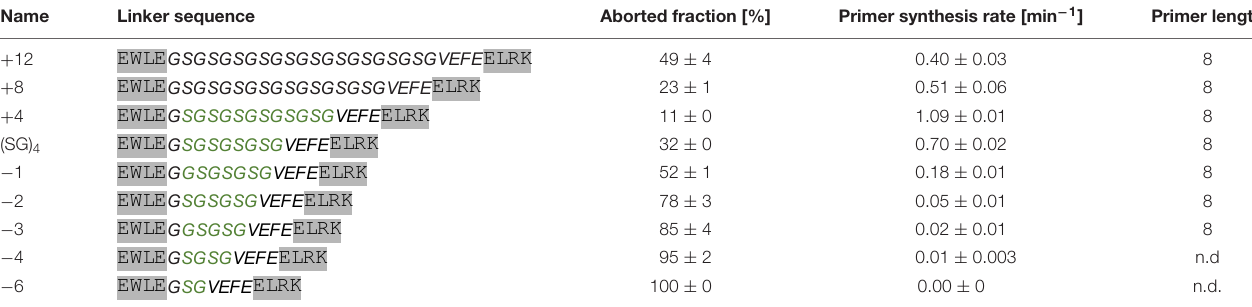
TABLE 4 | Primase activity of linker length mutants (template T 8 GTGT 3